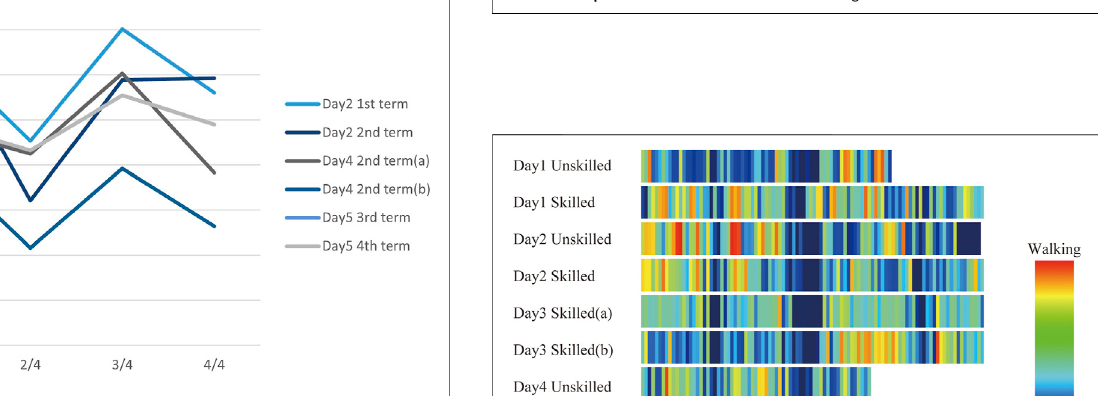
FIGURE 8 | The transition of the ratio of sitting.